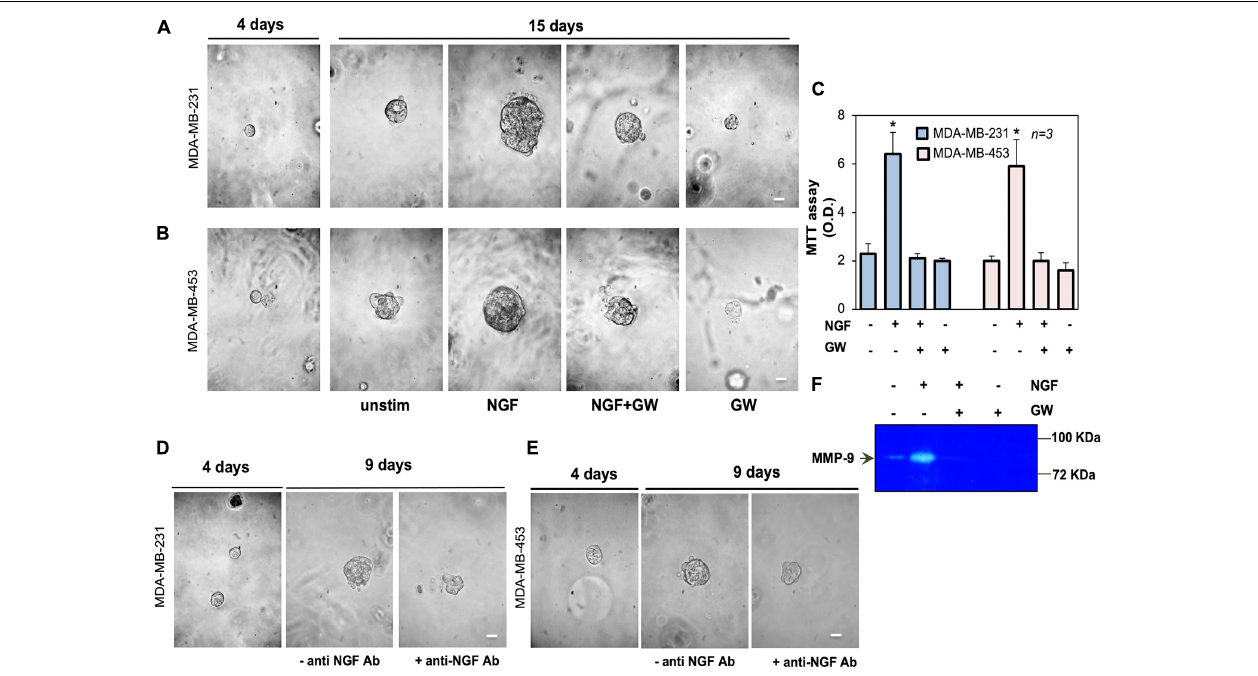
FIGURE 3 | Neurotrophin β -nerve growth factor (NGF) challenge increases the size of triple-negative breast cancer (TNBC) cell spheroids and the MMP-9 release. (A,B) MDA-MB-231 (A) and MDA-MB-453 (B) cells embedded in Matrigel were used. Four days later, representative images were acquired. Cells were left untreated or treated with 100 ng/ml NGF in the absence or presence of GW441756 (GW; 1 µ M) for 15 days. Shown are phase-contrast images, representative of three different experiments, captured on the 15th day. Scale bar , 100 µ m. (C) Spheroid viability was analyzed by the MTT assay after 15 days of treatment. Optical density (OD) was measured at 562 nm and the obtained results are shown in the graph. Means and SEMs are shown. n represents the number of experiments. (D,E) MDA-MB-231 (D) and MDA-MB-453 (E) cells were used to generate spheroids, as in (A,B) . Spheroids were left untreated for 9 days, avoiding refreshing the medium, in the absence or presence of the anti-NGF antibody (anti-NGF Ab). Shown are phase-contrast images, representative of three different experiments, captured at day 9. Scale bar , 100 µ m. (F) MDA-MB-31 cells were treated for 30 h with 100 ng/mL NGF in the absence or presence of GW441756 (GW; 1 µ M). The release of MMP-9 in conditioned media was analyzed by zymography. * p < 0.05 for the indicated experimental points vs. the corresponding untreated